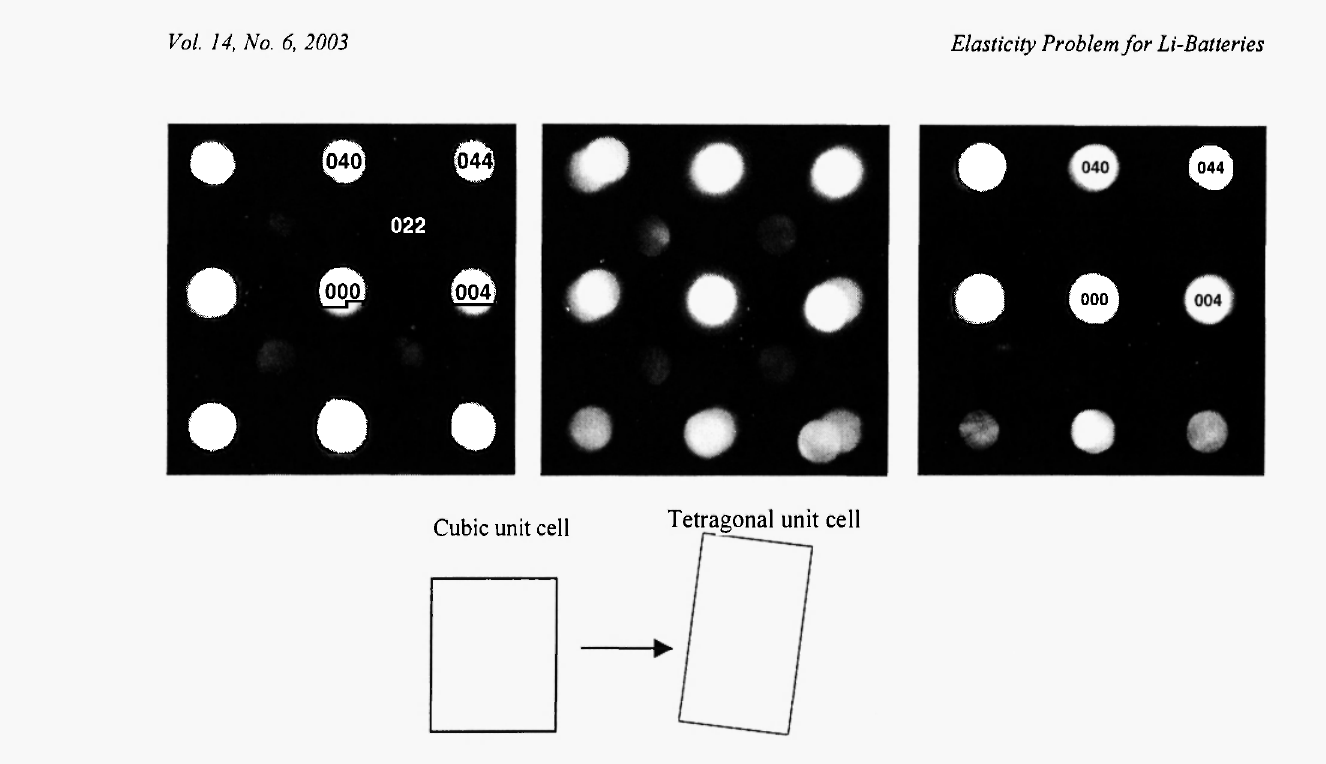
Fig. 2: When deep discharge occurs below 3.3 volts, the structure transforms from cubic to tetragonal with a 14% increase in unit cell volume. The reciprocal space representation below from the convergent beam electron diffraction pattern shows how the lattice both expands and rotates. Note the four fold symmetry of the cubic [100] pattern. The pattern intermediate between the cubic and tetragonal structures shows a two-phase structure in which the volume/symmetry change is accommodated by a lattice rotation. The mismatch between the cubic and tetragonal spinel structures results in a nearly five-degree rotation of the two unit cells.